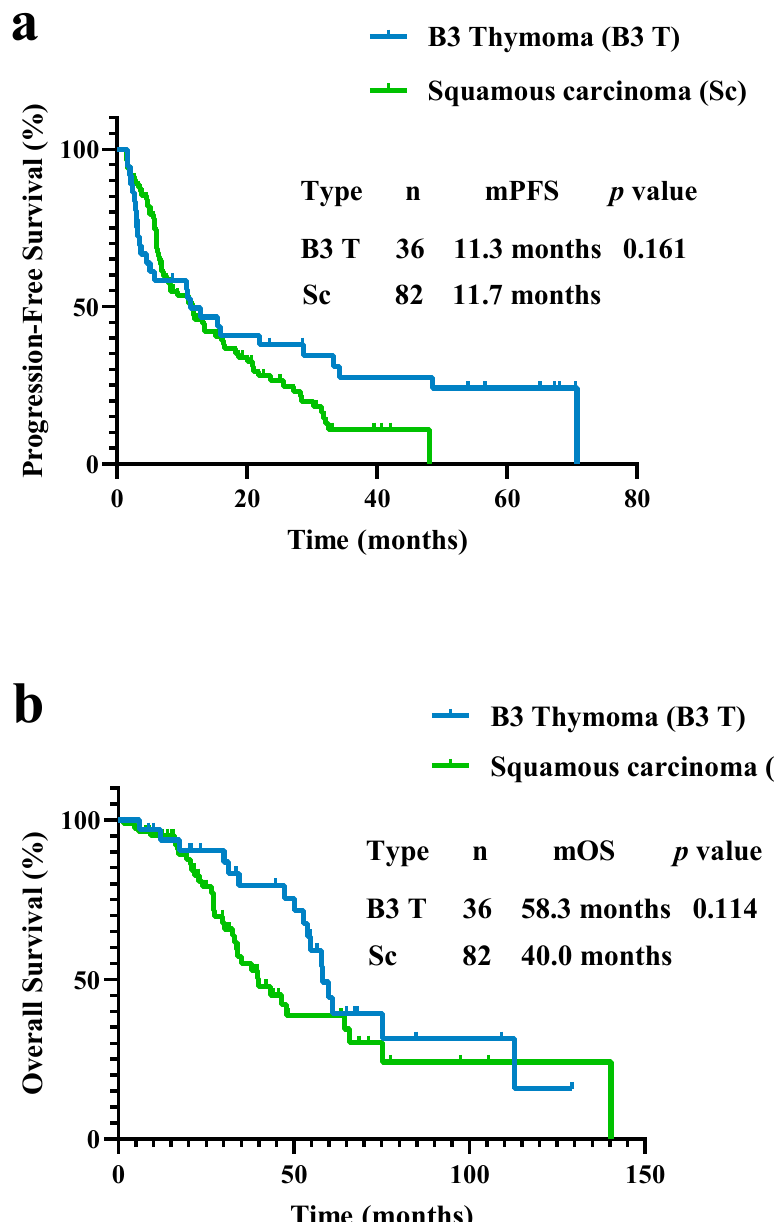
Figure 2. ( a ) PFS and ( b ) OS in patients with B3 thymoma and squamous carcinoma. PFS and OS did not differ between patients with B3 thymoma and squamous carcinoma (PFS, 11.3 vs. 11.7 months, p = 0.161; OS, 58.3 vs. 40.0 months, p = 0.114). The PFS was 6.5 months in the non-squamous carcinoma subgroup, which was lower than 11.3 months in the B3 thymoma group although the difference was not statistically significant ( p = 0.128; Figure 3a). However, a difference in OS between non-squamous carcinoma and B3 thymoma was observed (30.6 vs. 58.3 months, p = 0.031; Figure 3b). Different therapy regimens did not exhibit any differences in survival. Patients who received paclitaxel regimen had a similar PFS compared to patients receiving non-paclitaxel regimen (11.4 vs. 6.8 months, p = 0.689). The OS results were similar (43.4 vs. 47.4 months, p =